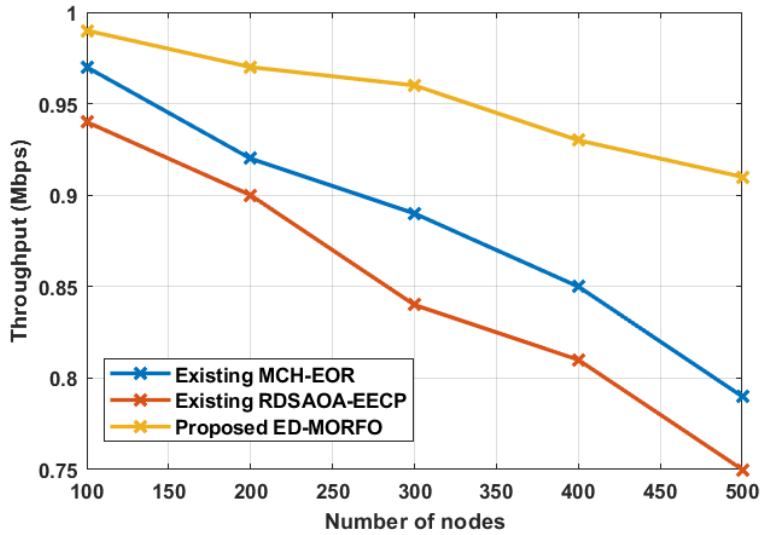
Figure 5. Performance analysis of throughput for proposed EDMORFO and Existing MCH-EOR [24], RDSAOA-EECP [25]. Table 4. Performances of